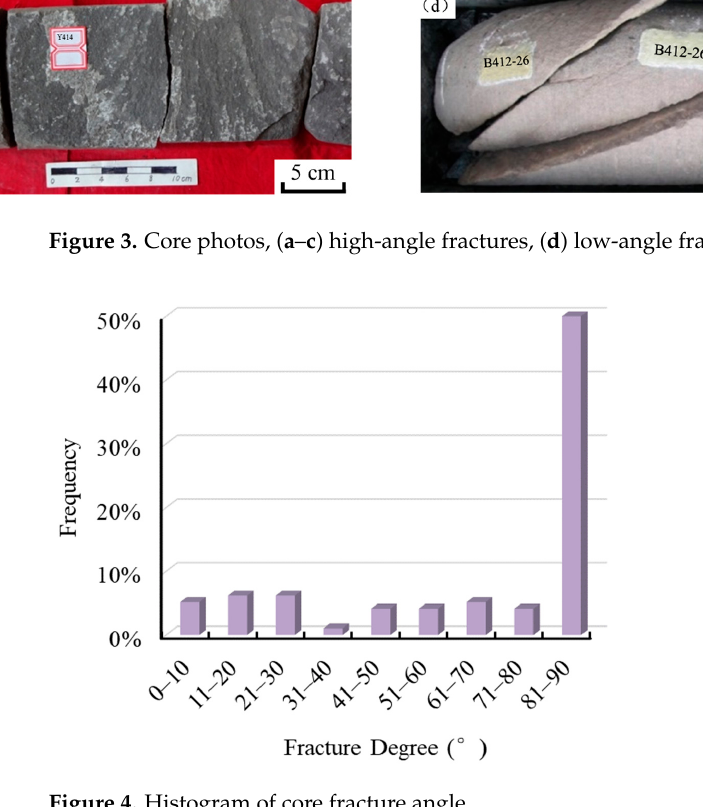
Figure 4. Histogram of core fracture angle.